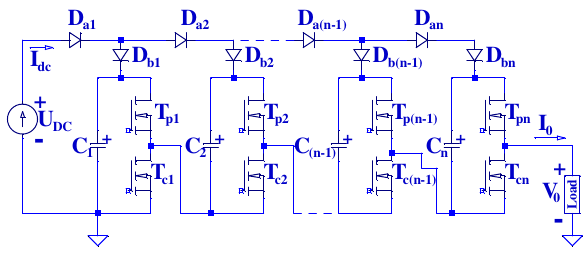
FIG. 8. Simplified schematic of a solid state Marx